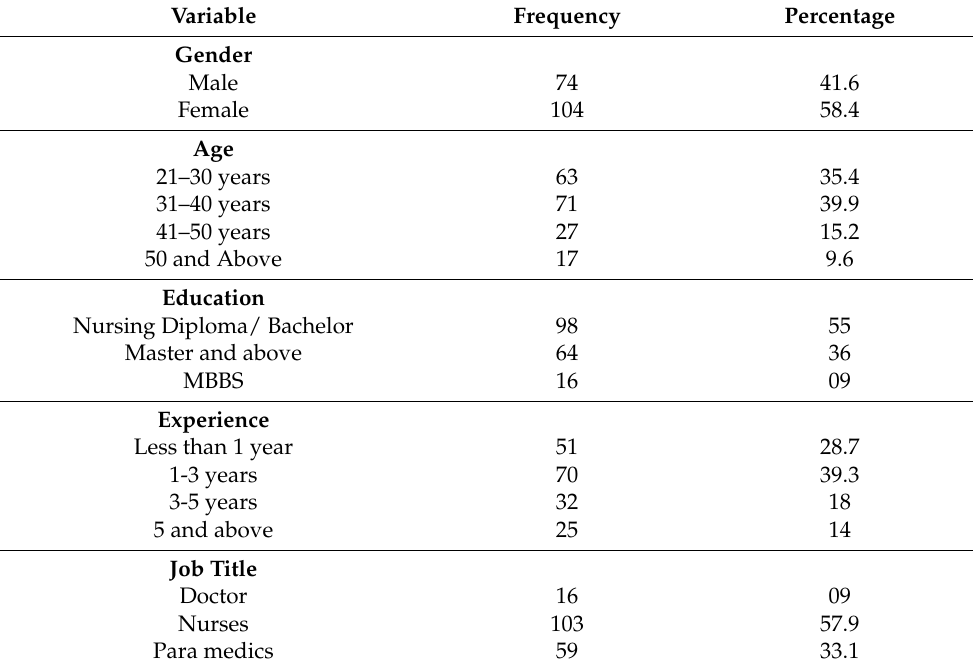
Table 1. Respondents